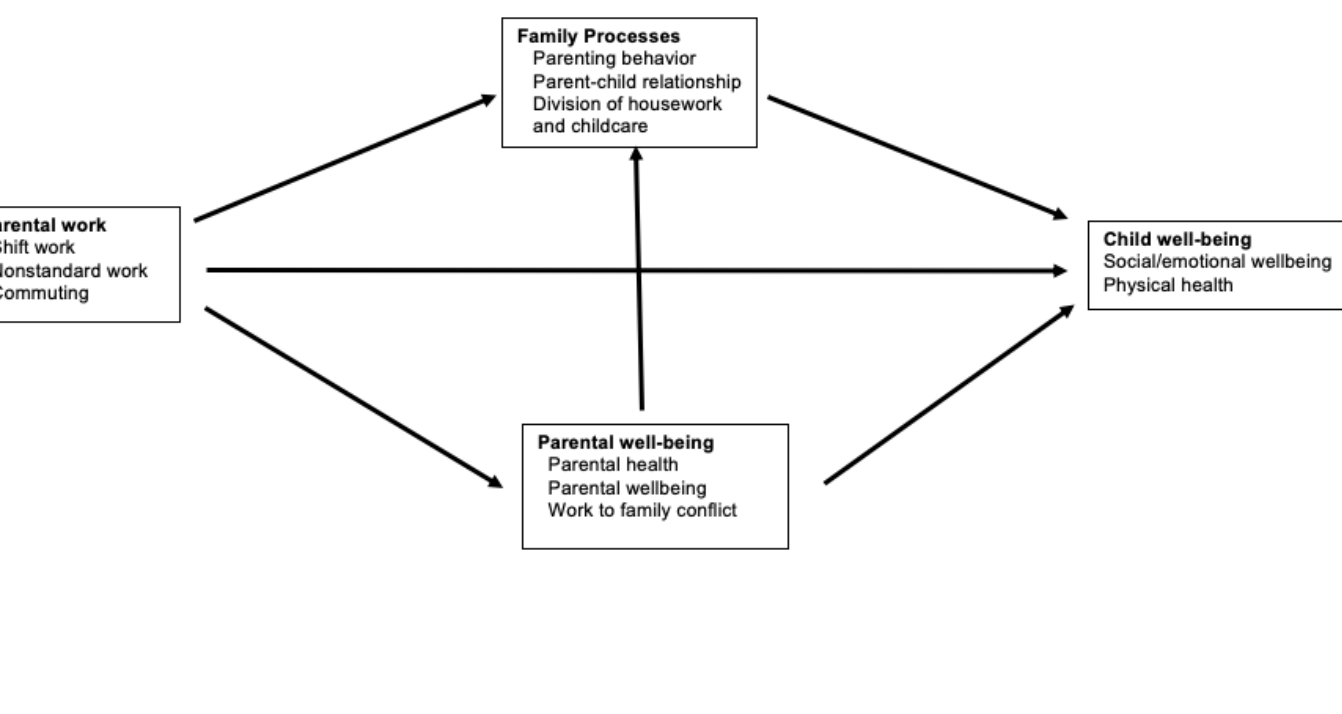
Figure 1 : Pathways linking parental work to child and family